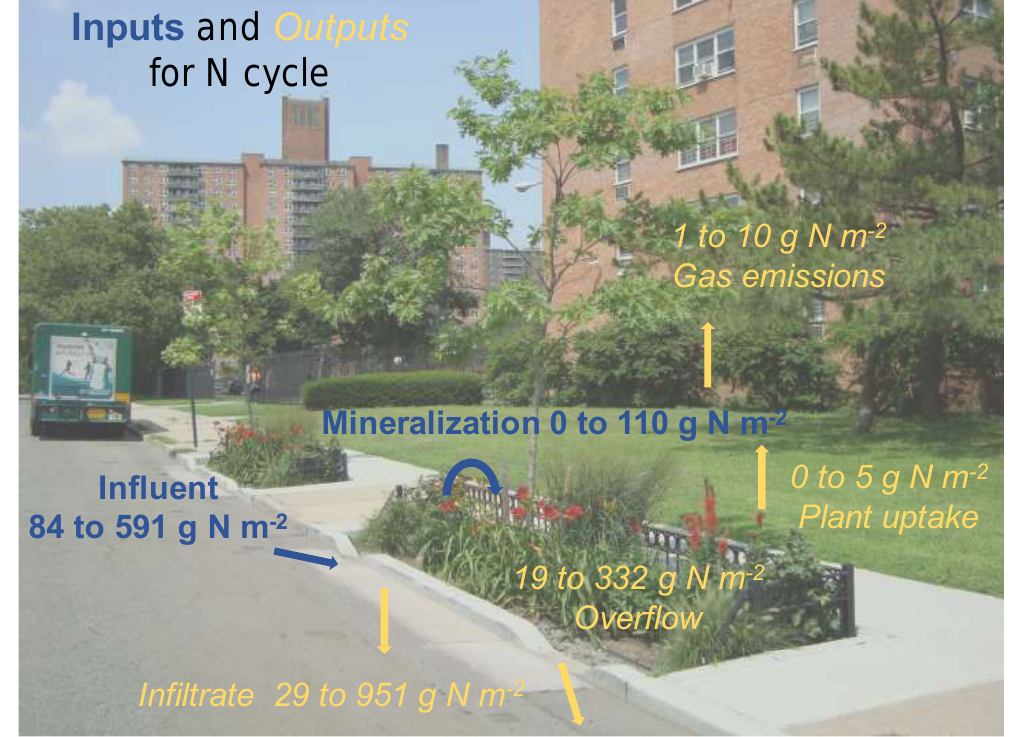
Figure 11. Approximate nitrogen mass balance with site ROWB 9A in the foreground and site ROWB 9B in the background.